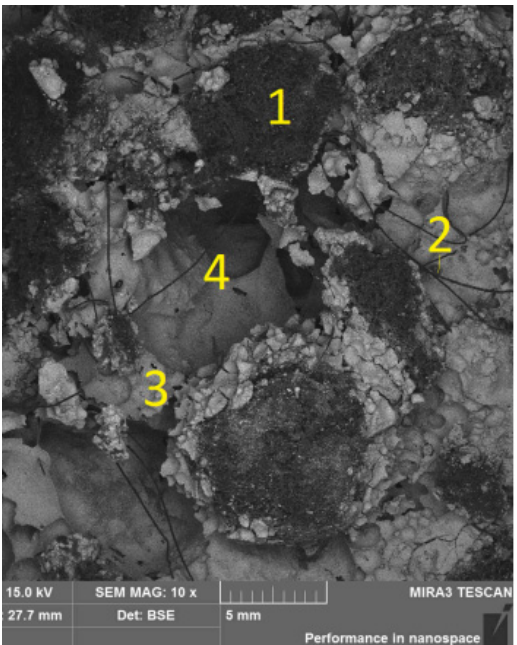
Figure 3. Microstructure of a sample of polystyrene concrete, 10 × magnification. 1—polystyrene, 2—micro-reinforcement, 3—fine-grained matrix, and 4—voids, pores.